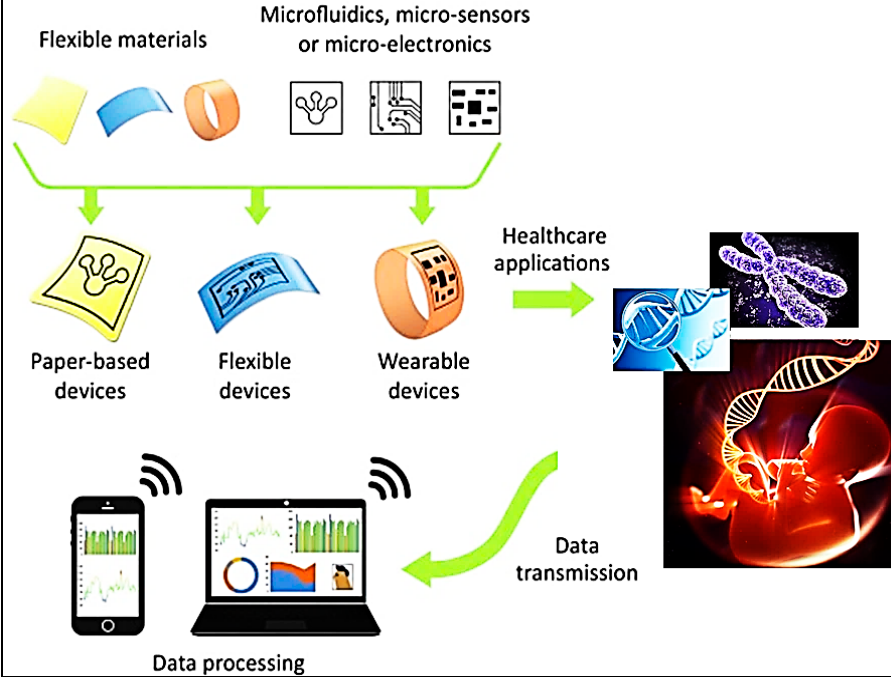
Figure 8. Overview on the working of flexible devices for POC diagnosis. (We discuss recent ad- vancements in the multiplexing capabilities and sensitivity of paper-based POC diagnostics, and then discuss the development of flexible polymer-based POC diagnostics for sensing biological targets, as well as their prospective uses as wearable